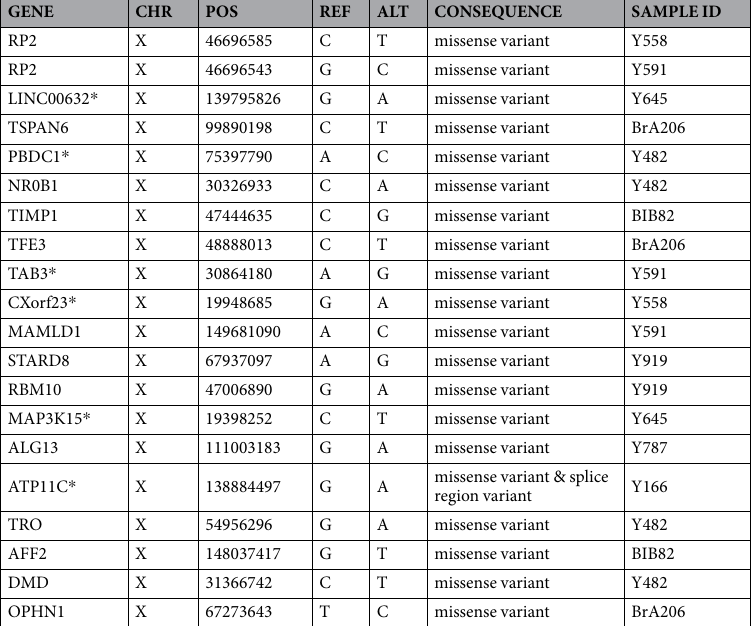
Table 5. Putative recessive loss of function X-linked candidate genes with hemizygous variants in male suicide victims.CHR and POS show the GRCh37 coordinate of the variant; the REF/ALT columns shows the reference and alternate alleles; the CONSEQUENCE is the type of the protein disruption; the SAMPLE ID column contains the sample name in which the given variants were found in heterozygote state. * denotes gene without disease association in MalaCards and OMIM.